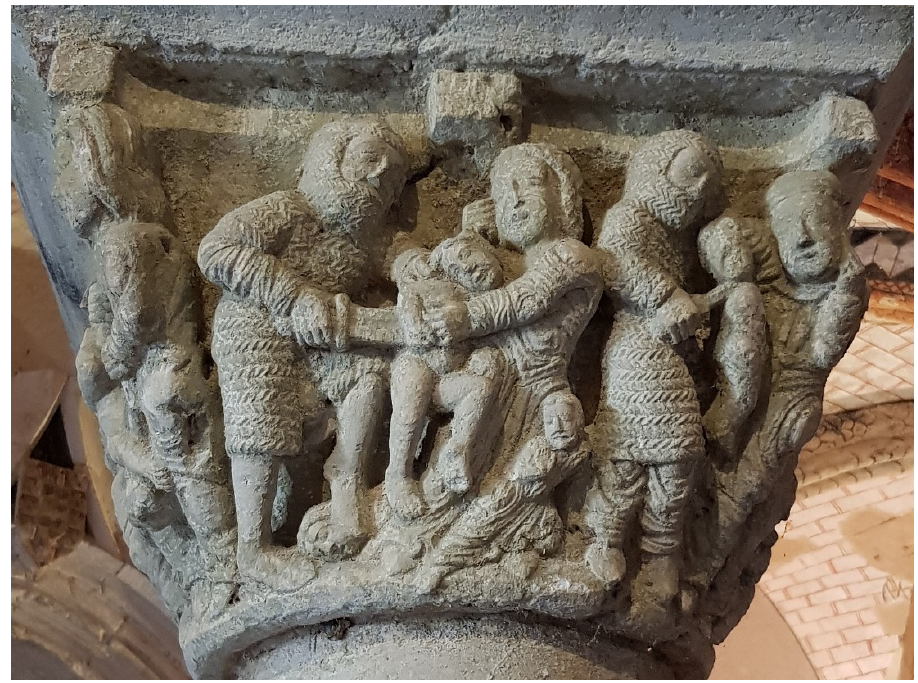
Figure 8. El Burgo de Osma. Chapterhouse. Capital of the Massacre of the